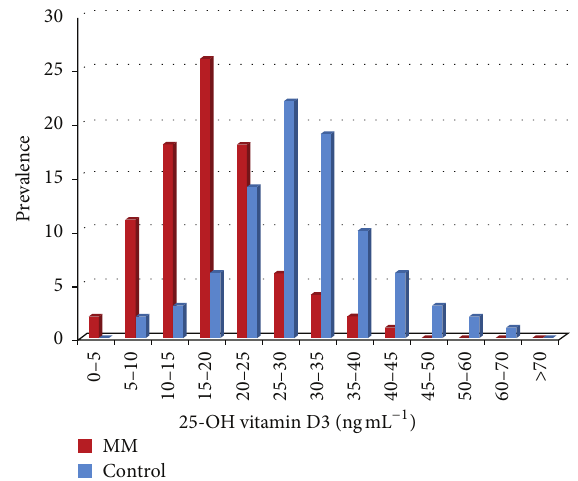
Figure 3: 25-OH vitamin D3 serum level (ngmL −1 ) in melanoma patients (MM) compared to controls. Prevalence depicts the sub- groups of low serum 25-OH vitamin D3 in the melanoma group of patients.